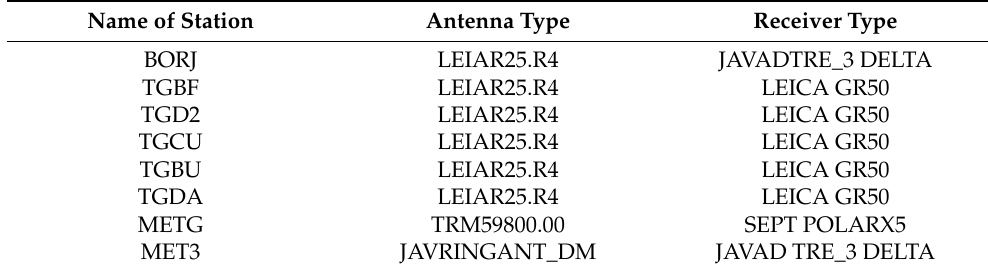
Table 1. Information of the selected stations.